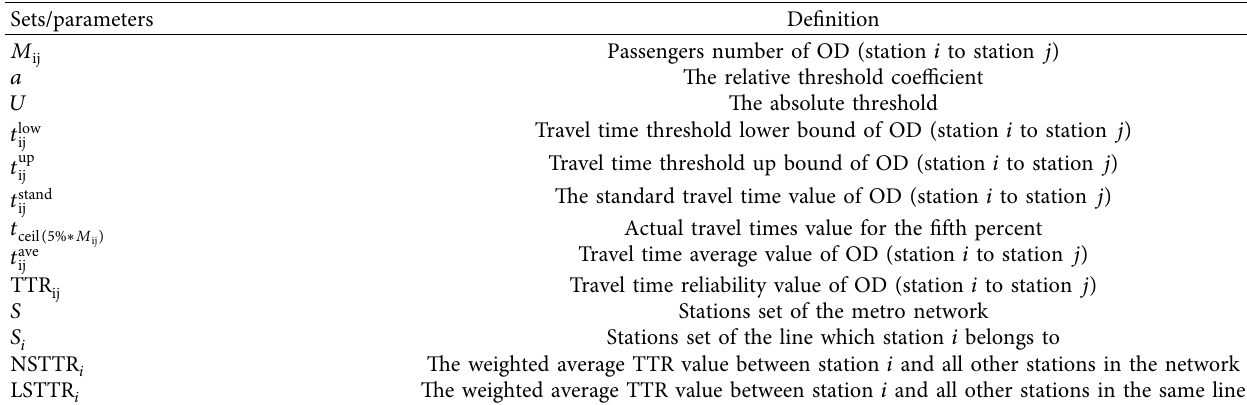
Table 3: Relevant sets and parameters in model